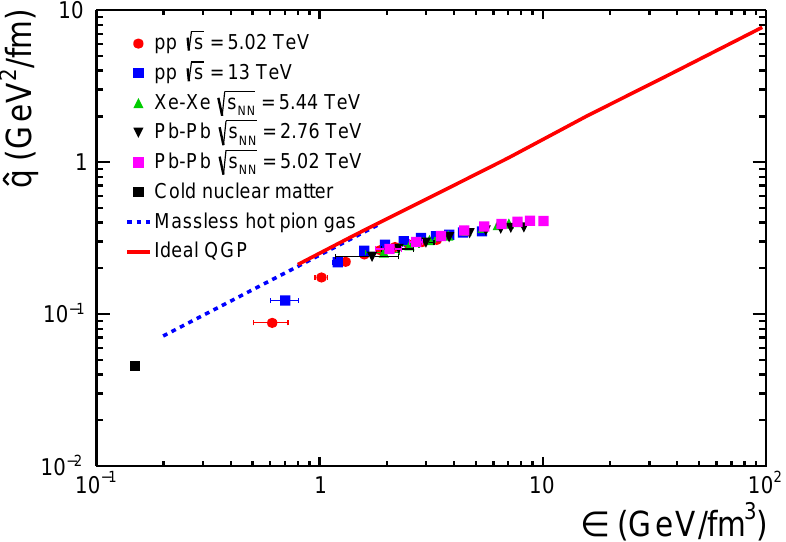
Figure 6. Jet quenching parameter, ˆ q , as a function of initial energy density for pp collisions at √ √ √ s = 5.02 and 13 TeV, Xe-Xe collisions at s NN = 5.44 TeV and Pb-Pb collisions at s NN = 2.76 and 5.02 TeV. The blue dotted line is for massless pion gas, the solid red curve is for ideal quark-gluon plasma (QGP) and the black square is for cold nuclear matter